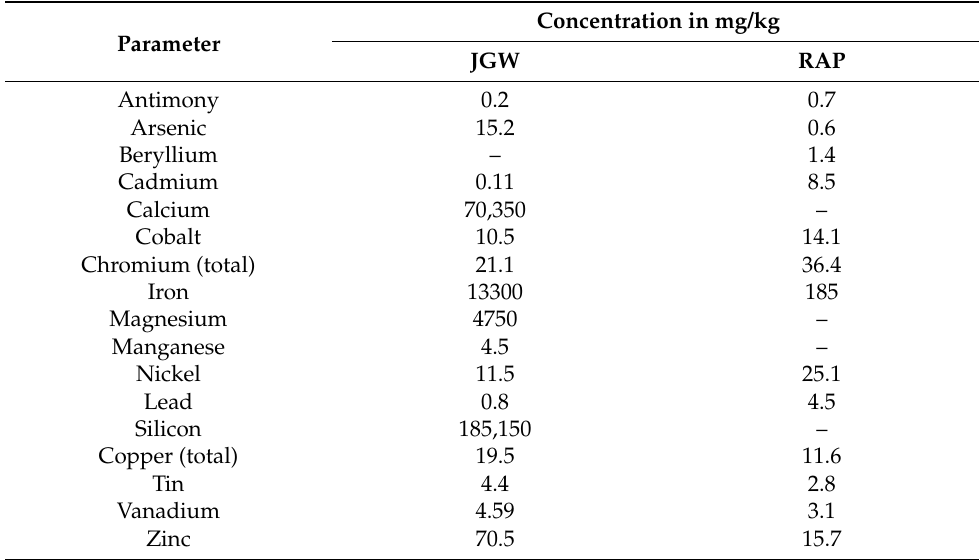
Table 3. Chemical compositions of JGW and RAP.